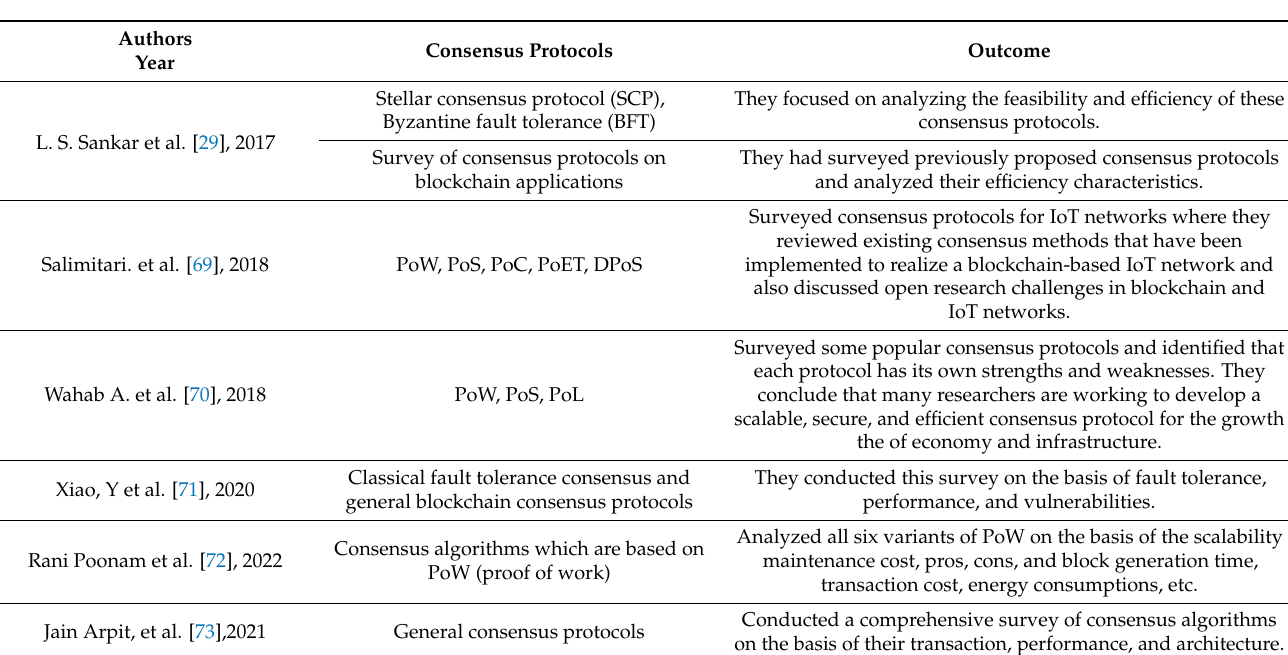
Table 5. Previous surveys and their